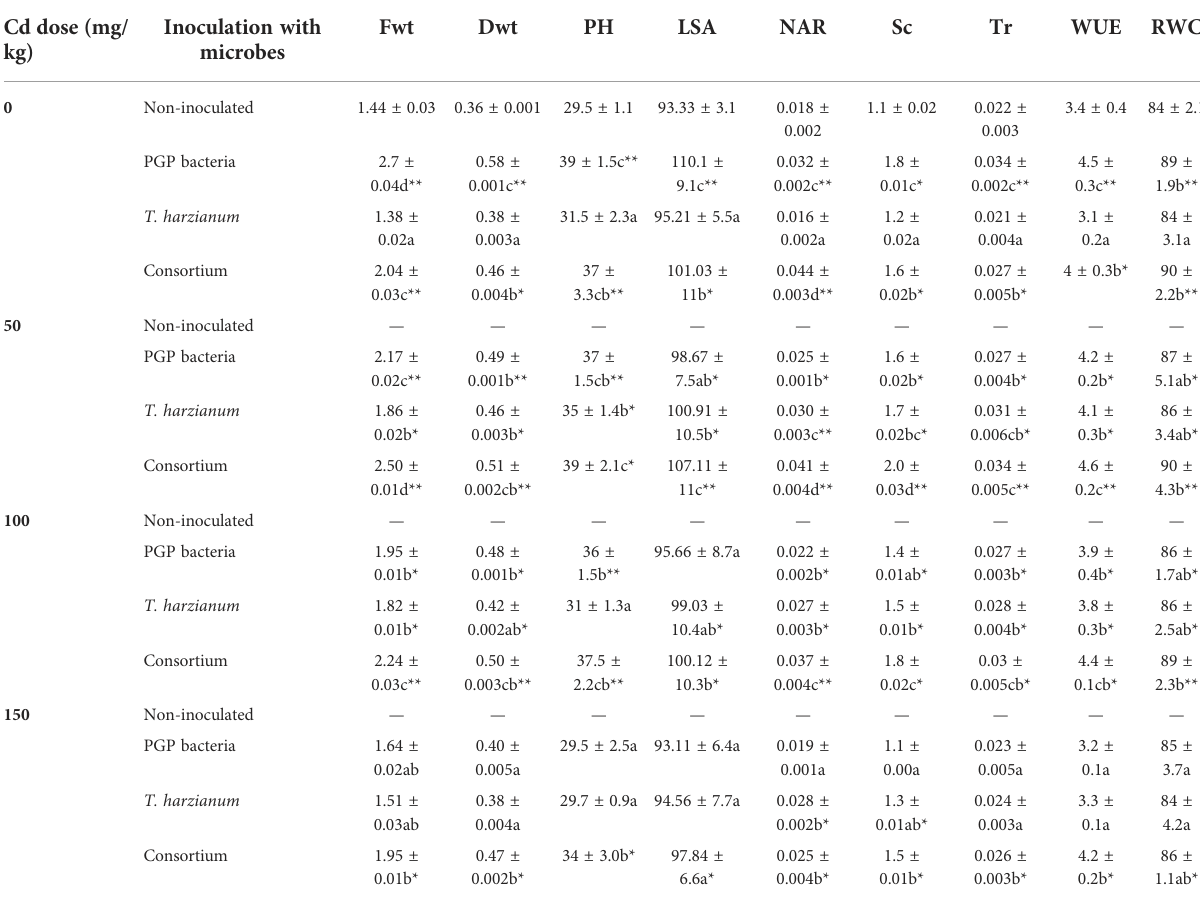
TABLE 2 Average values of Fwt, g/plant; Dwt, g/plant; PH, cm; LSA, cm 2 ; NAR, µg/cm 2 /d; Sc, mol/m 2 /s; Tr, water loss/leaf area; WUE, g DW/kg H 2 O; RWC, % of sun fl ower inoculated and non-inoculated with PGP bacteria, T. harzianum , and Consortium and affected by different levels of Cd (0, 50, 100, and 150 mg/kg dry soil). Cd dose (mg/